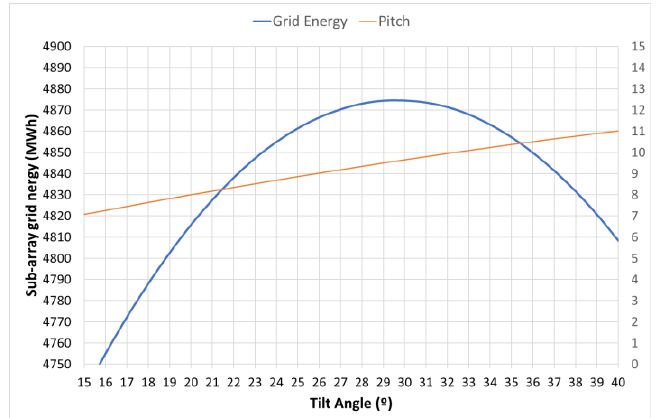
Figure 4. Sub-array grid injected energy and pitch variation as a function of tilt; 18 ◦ shading limit angle; landscape; central inverter.